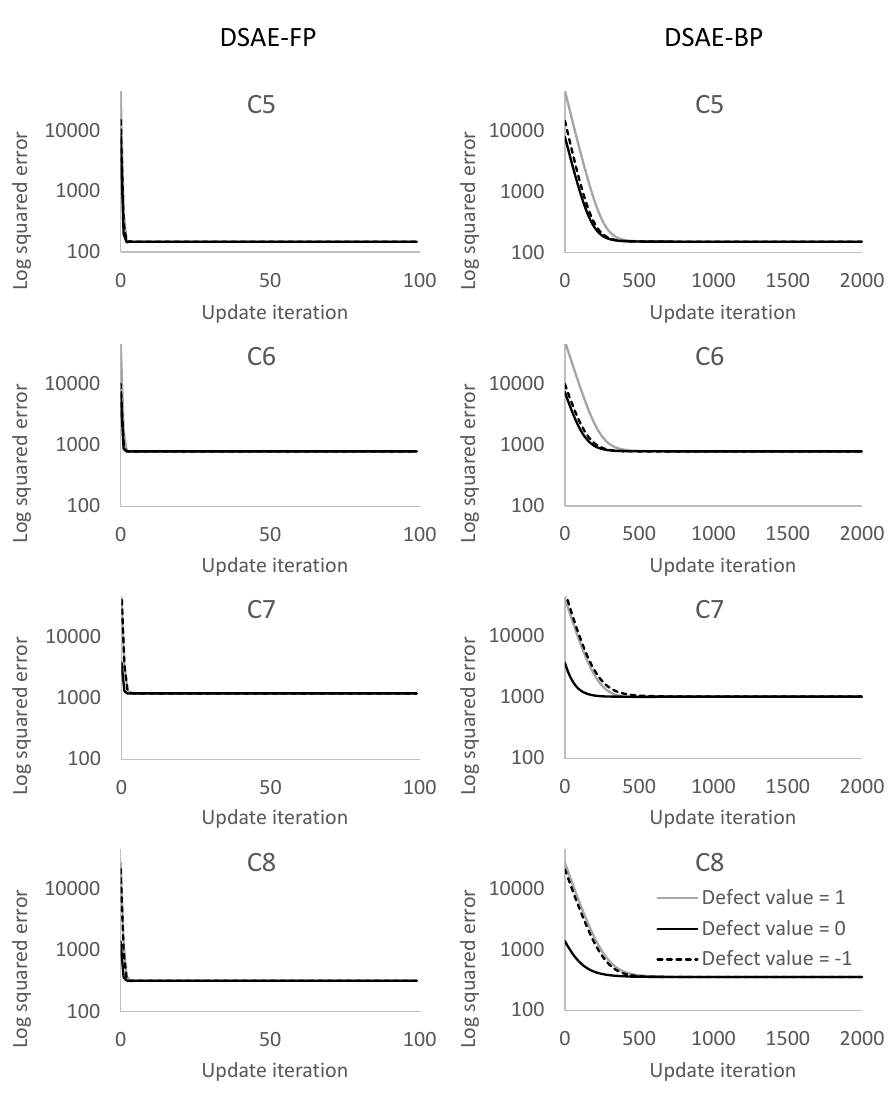
Figure 11. Square error between the repaired sensor time-series data and non-defective sensor time-series data for C5 to C8 at each update iteration. The plots in the columns on the left and right represent the results obtained by using DSAE-FP and DSAE-BP, respectively.